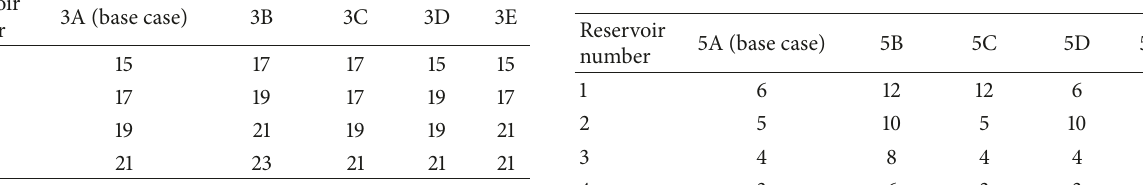
Table 7: Five cases with different reservoir logging permeabilities ( × 10 −3 𝜇 m 2 ).